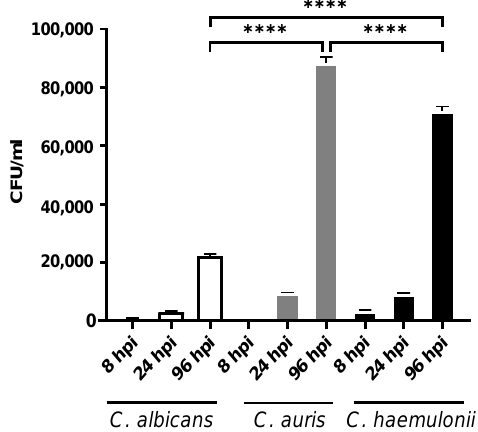
Figure 3. Fungal burden in zebrafish model. Each experimental group of five zebrafish was injected with 10 7 cells of one of the C. albicans ATCC24433 (control) strain, C. auris strain SI-18-CAU-HEM, and C. haemulonii strain SI-21-CH-PLF. Each experiment was performed in triplicate. Abbreviations and symbols: CFU/mL, colony forming unit per milliliter; ****, p < 0.0001.